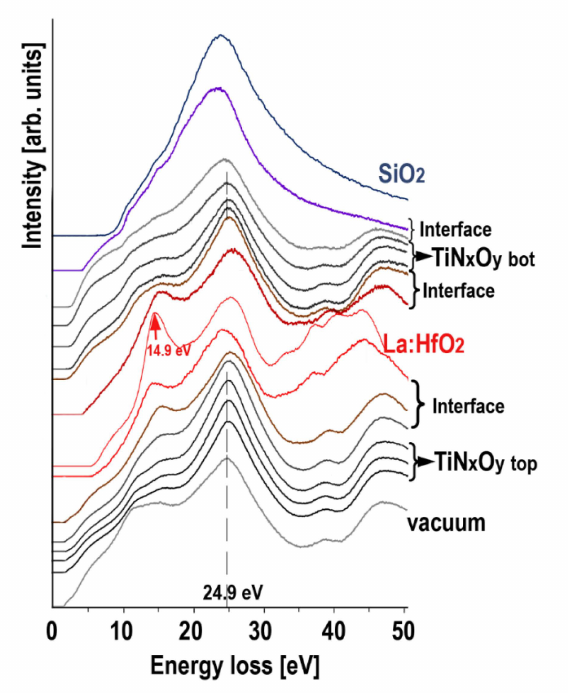
Figure 8. Energy loss functions obtained from the TiN x O y top, La:HfO 2 , TiN x O y bottom layers and SiO 2 to estimate the energy band gaps; the 24.9 eV and 14.9 eV plasmon energies are given for TiN x O y and of for La:HfO 2 ,